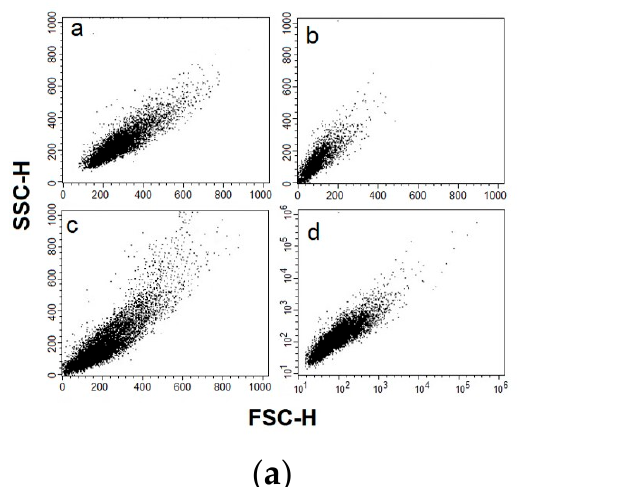
Figure 4. FACS analysis of Trypanosoma cruzi epimastigotes cell volume populations. ( a ) Forward light scatter (FSC-H) was considered as a function of cell size, and side light scatter (SSC-H), as a result of cell granularity. Density plots for FSC versus SSC in T. cruzi epimastigotes after 72 h treatment with Nifurtimox (Panel (b)), ST18 (Panel (c)) and TR4 (Panel (d)). Untreated control is represented in Panel (a). ( b ) Representative FACS histogram showing FSC-H and SSC-H of T. cruzi epimastigotes after 72 h treatment with Nifurtimox (Panels (a) and (d)) ST18 (Panels (b) and (e)) and TR4 (Panels (c) and (f)). Thin line: Non-treated control parasites; thick line: Parasites treated with each compound. Data are representative of three separate experiments.